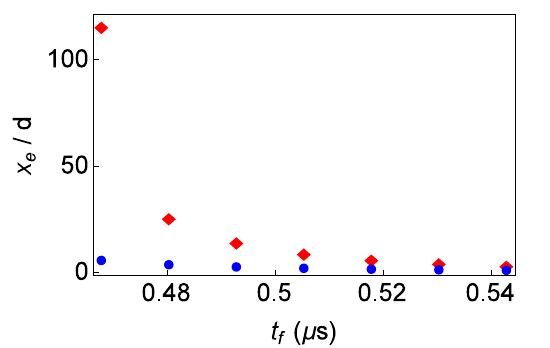
Table 1. Minimal times for the transport + expansion process when the trap frequency or/and center are limited, see text. Parameters: = d